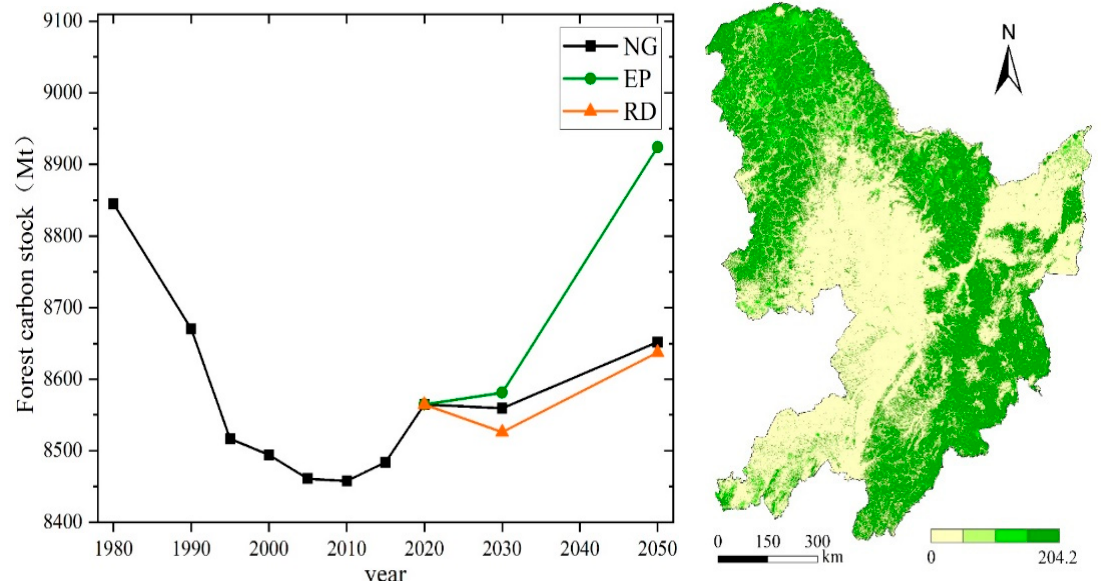
Figure 11. Change trend of forest carbon storage and spatial distribution of carbon storage in 2020 (Mg/hm 2 ).